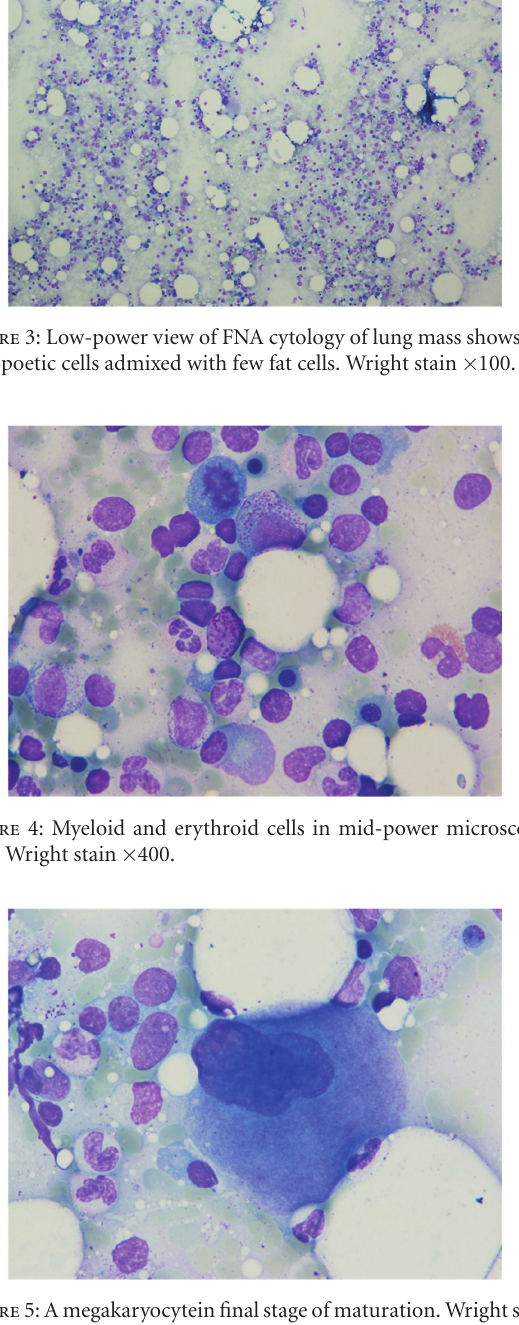
Figure 5: A megakaryocytein final stage of maturation. Wright stain ×